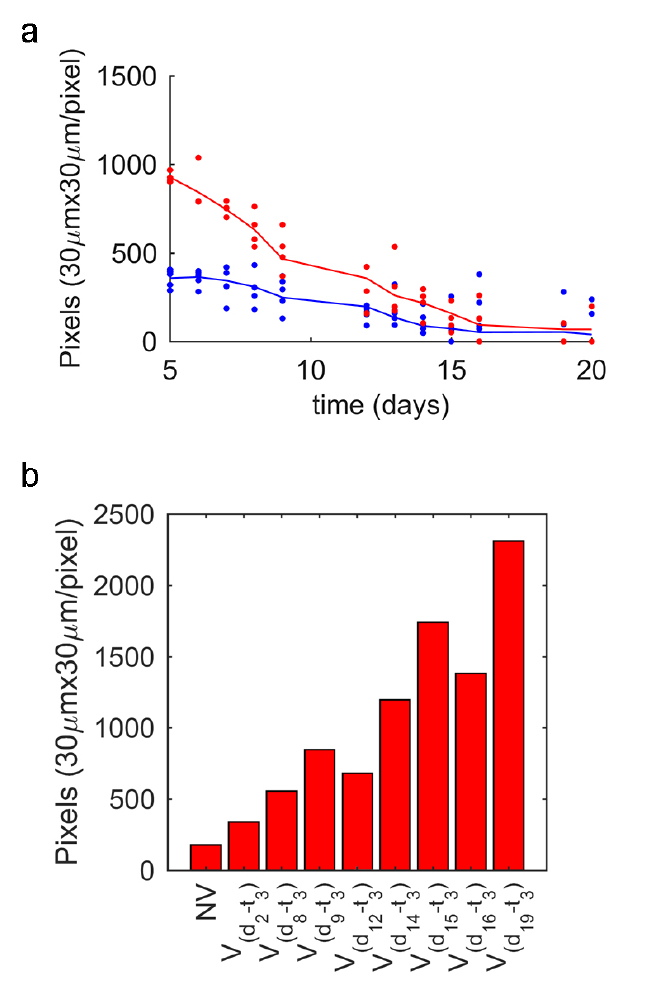
Figure 8. Ageing effect. ( a ) Amount of movement (area in pixels) in time, blue line denotes the NVcondition and the red line is V d (vibration started on day 2); ( b ) This figure shows the same as the previous one, 2 − t 3 but with details of day 19. Each bar is a condition (left to right) to represent from the lowest stimulus V ( d 2 − t 3 ) to the highest V ( d 19 − t 3 )